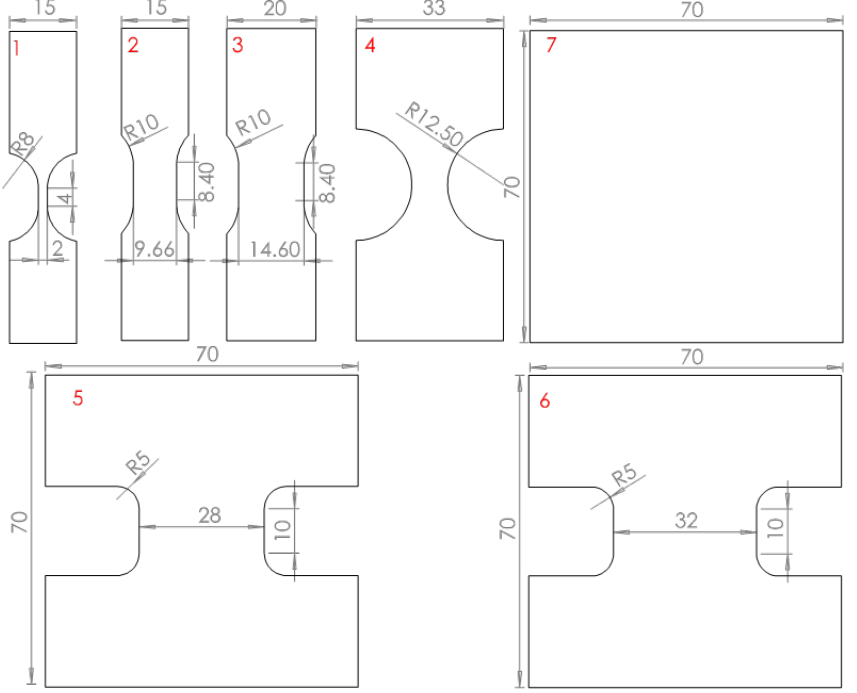
Figure 3. Sample geometries used to determine the FLDs (Reproduced with permission from [42]; Copyright Elsevier, 2020).